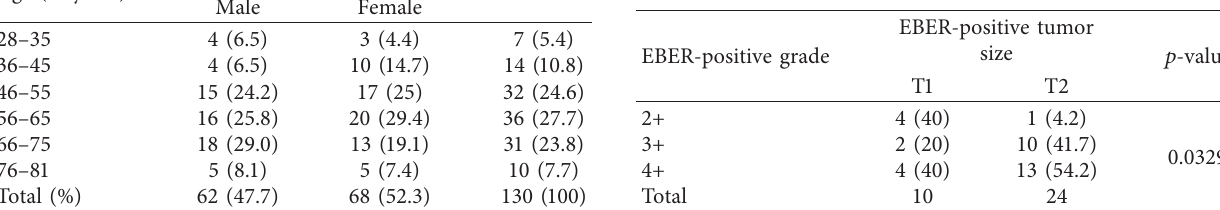
Table 4: The relationship between the grade and tumor basal dimension in EBER-positive SGC of the eyelid. T1 was the tumor basal dimension between 6 and 10mm. T2 was the tumor basal dimension more than 10mm.